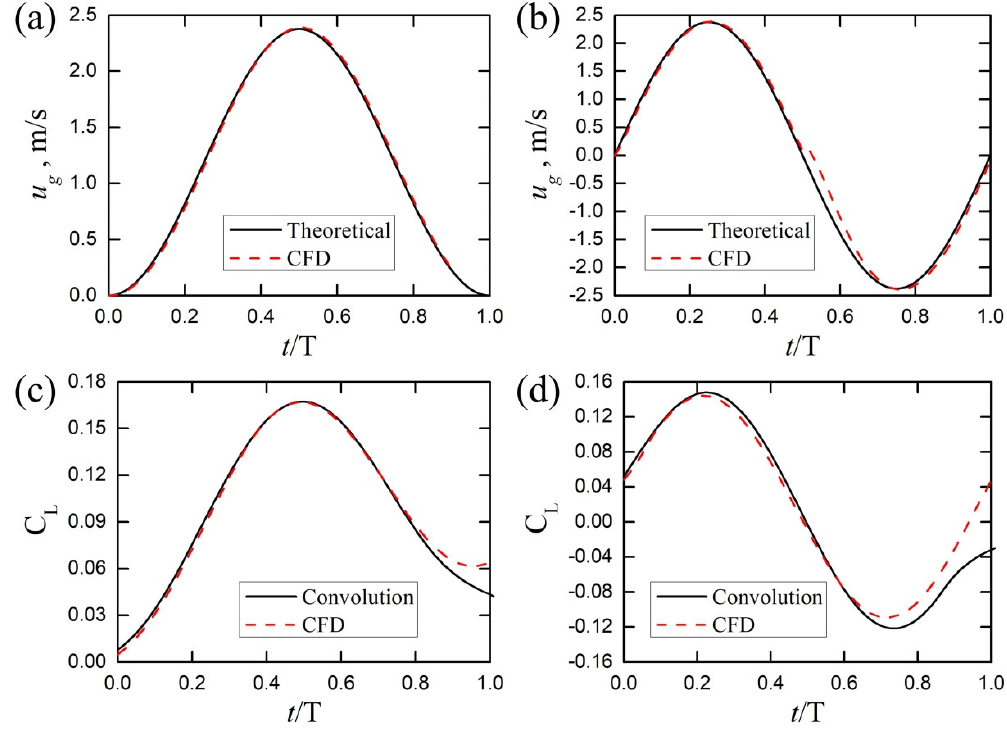
Figure 17. Comparisons of ( a ) the 1-cosine and ( b ) sinusoidal vertical gust velocity profiles between the theoretical and current CFD results, followed by comparisons of lift coefficient (C L ) responses of the NACA 0006 airfoil to the two gusts in ( c ) and ( d ), respectively. Table 4. Values of the material parameters for the inlet gust response calculations.